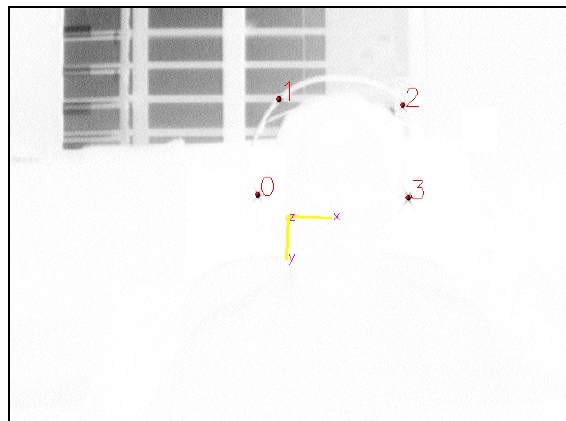
Figure 4. Images showing the detection process during the operation of the system. The four infrared LEDs detected are marked by red dots over the raw images captured by the camera (notice that the colors are inverted). The computed coordinate frame is also shown as an overlay on the image